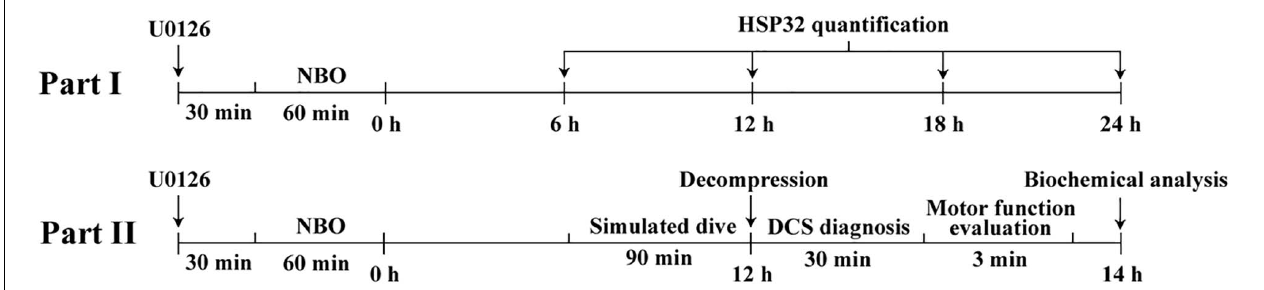
FIGURE 1 | The timeline and design of the study. Part I, NBO-U0126 treatment-induced HSP32 expression in rat spinal cord was determined at 6, 12, 18, and 24 h following NBO exposure. The separate NBO and U0126 treatment HSP32 samples were collected at 12 h following NBO exposure. Part II, rats in different treatment groups underwent simulated air dives, concluding that at the HSP32 peak time point of 12 h, DCS diagnosis, motor function evaluation, and sample collection for biochemical analysis were successively carried